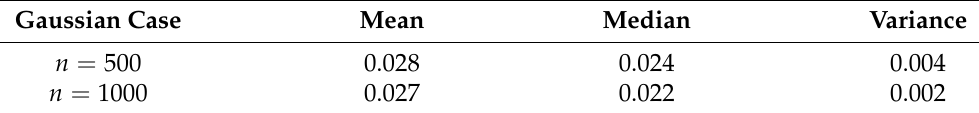
Figure 4. On the left plot: the non-parametric function η ( . ) versus its estimator ˆ η ( . ) , Gaussian case. On the right plot: the non-parametric function η ( . ) versus its estimator ˆ η ( . ) , logistic case. Table 11. The RASE criterion with the non-parametric function η ( . ) for both cases n = 500 and n = 1000.